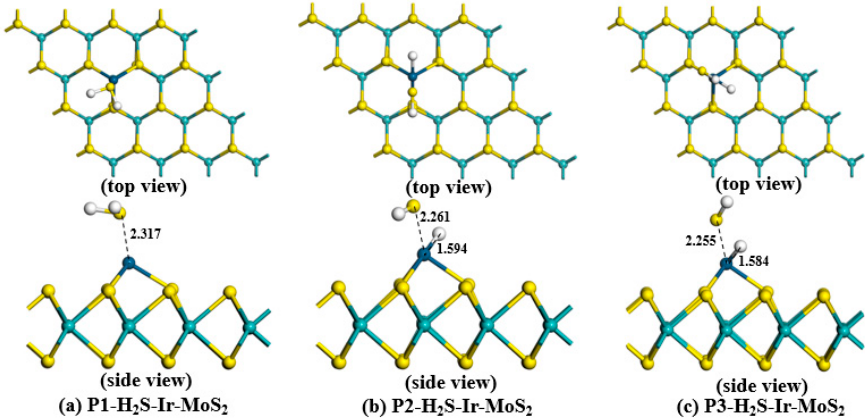
Figure 4. Various optimized configurations of H 2 S-Ir-MoS 2 adsorption systems.